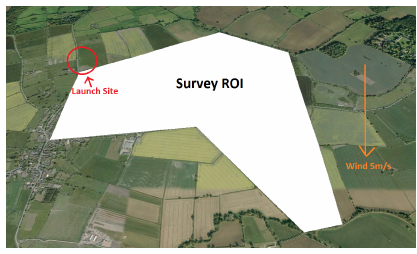
Figure 19. Large example farm field to survey, with a northerly wind of 5 m/s, also showing a launch and landing point for the survey aircraft.